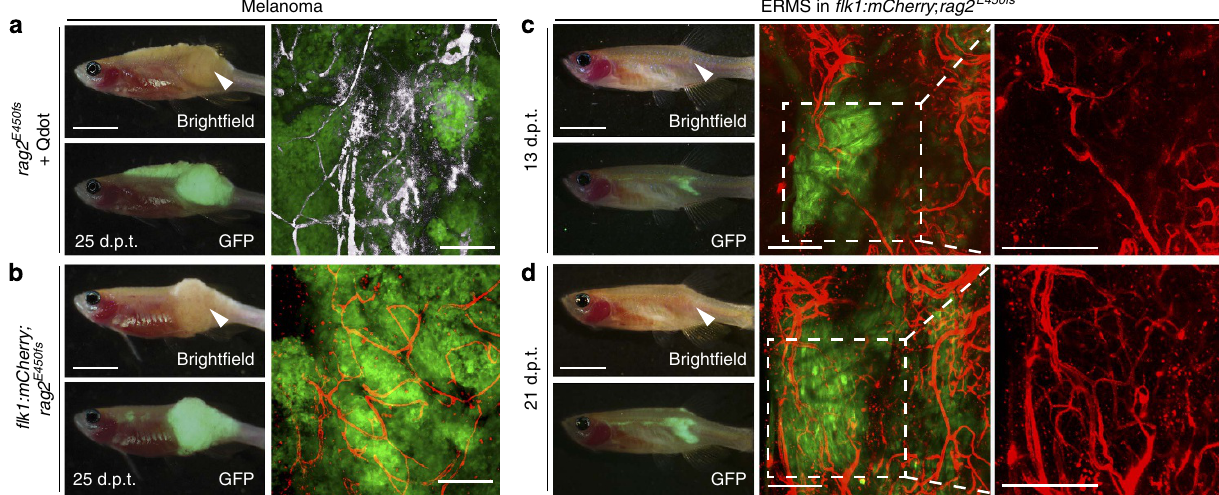
Figure 2 | Imaging neovascularization in rag2 E450fs (casper) zebrafish engrafted with fluorescently labelled melanoma and ERMS. ( a ) GFP-labelled, amelanotic melanoma implanted into rag2 E450fs (casper) fish ( n ¼ 8 animals) and imaged following intravascular injection of crimson quantum dots (Qtracker 655). Whole animal images to the left and confocal images to the right ( (cid:3) 100 magnification, 100–200 m m z-stack). Quantum dot fluorescence has been pseudo-coloured white. ( b ) GFP-labelled, amelanotic melanoma implanted into flk1:mCherry; rag2 E450fs (casper) transgenic zebrafish ( n ¼ 4 animals). ( c – d ) GFP-labelled ERMS engrafted into flk1:mCherry; rag2 E450fs (casper) transgenic zebrafish ( n ¼ 5 animals) and serially imaged over time ( c , 13 d.p.t. and d , 21 d.p.t.). White arrowheads denote the site of intra-muscular injection of tumour cells. Scale bars equal 5mm in whole animal images and 200 m m in confocal